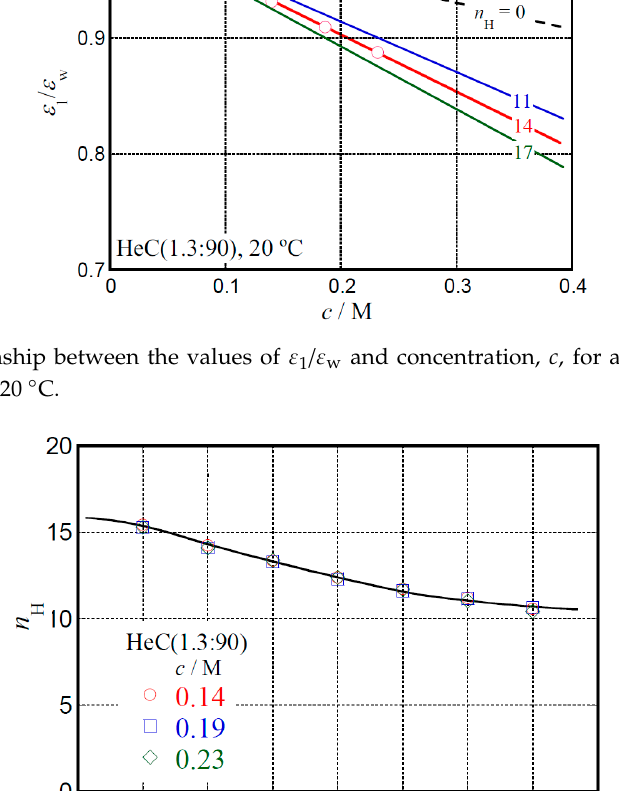
Figure 5. Relationship between the values of ε 1 / ε w and concentration, c , for aqueous solution of HeC(1.3:90) at T = 20 °C.